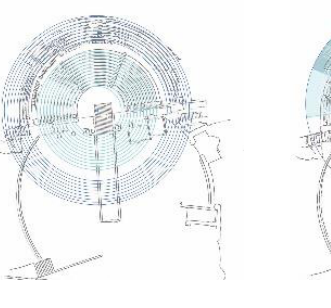
Figure 11: Extraction of main geometrical